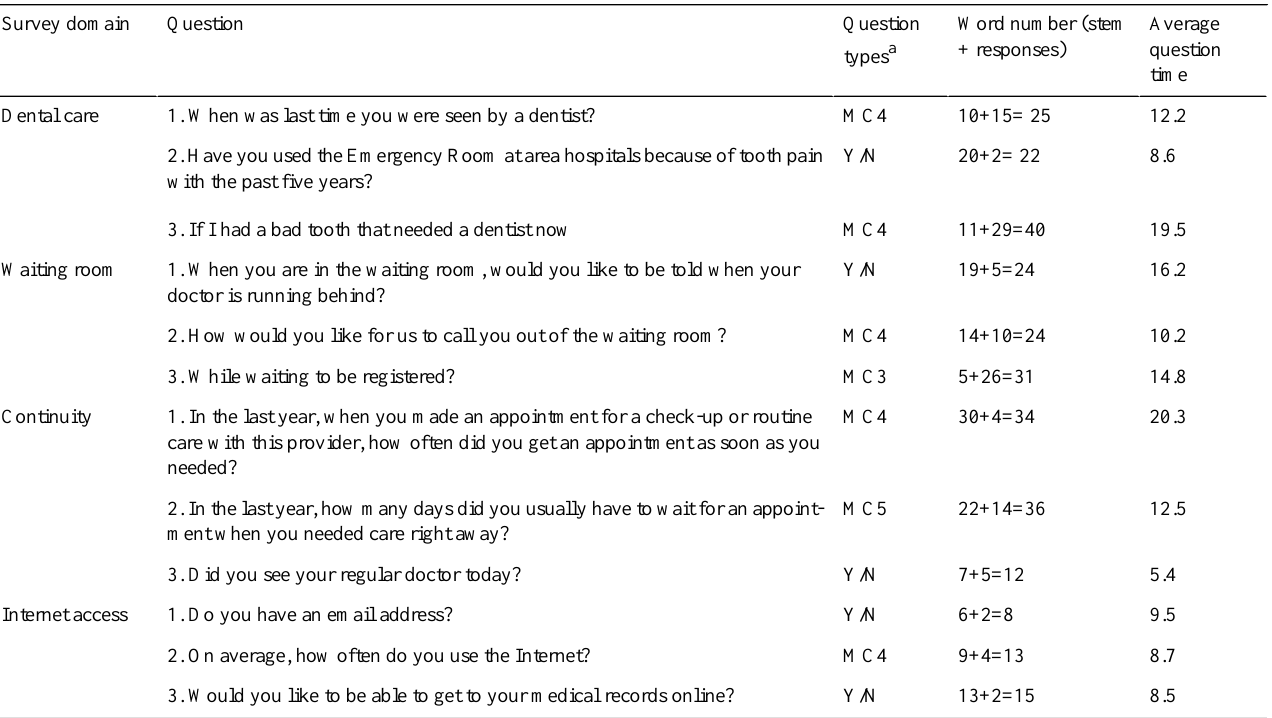
Table 2. Average respondent time by individual